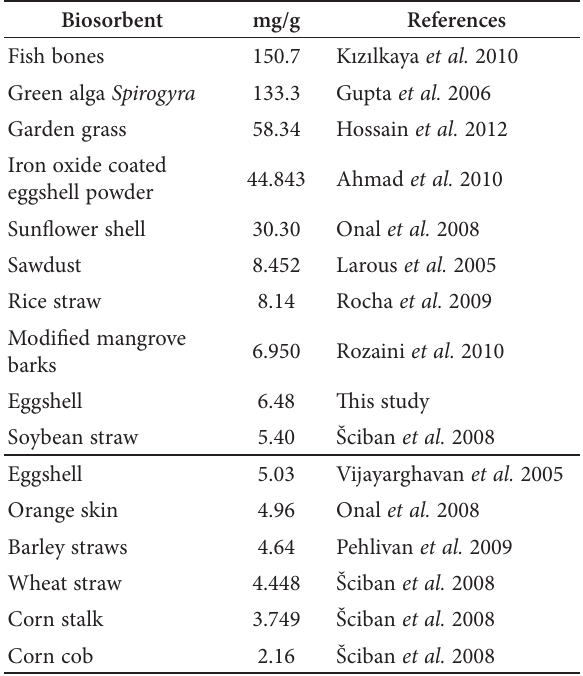
Table 3. Comparison of various biosorbent for Cu 2+ removal